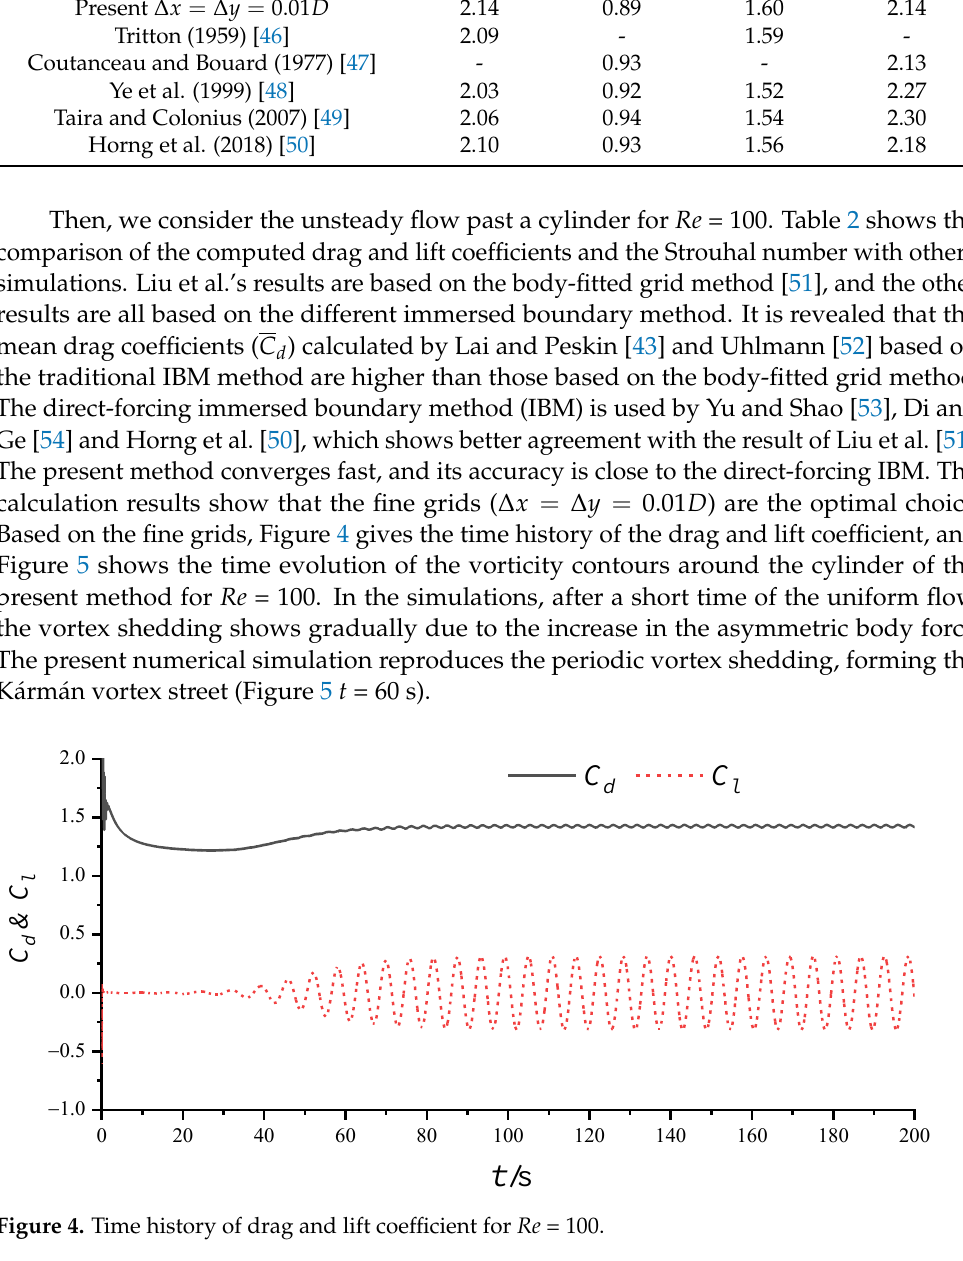
Figure 5. Vorticity contours of the flow around the circular cylinder for Re = 100.